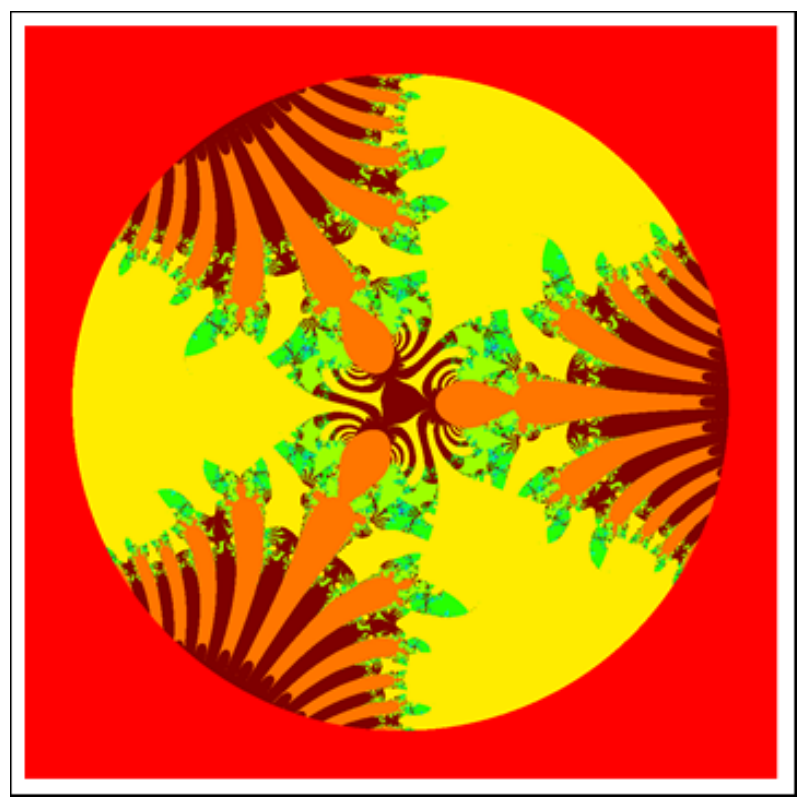
Figure 14. J-set for τ ( z ) = e z 3 + c via DKIS. The image execution time is 750.265 s.